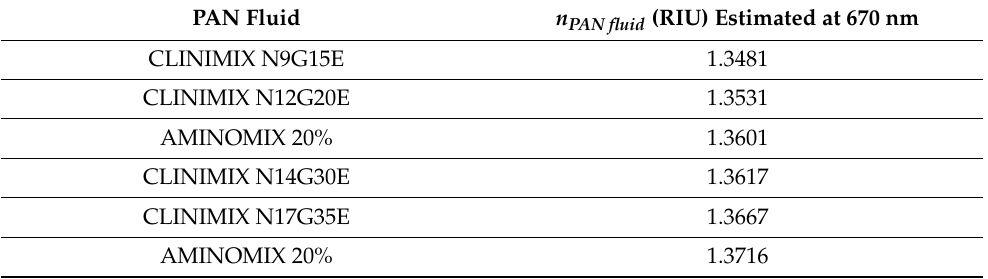
Table 1. List of commercial PAN solutions provided by the pharmacy of the I.R.C.C.S. San Matteo for experimental testing. Commercial names (first column); theoretical RI values estimated by Equation (1) at the wavelength of 670 nm (second column). PAN Fluid n PAN fluid (RIU) Estimated at 670 nm CLINIMIX